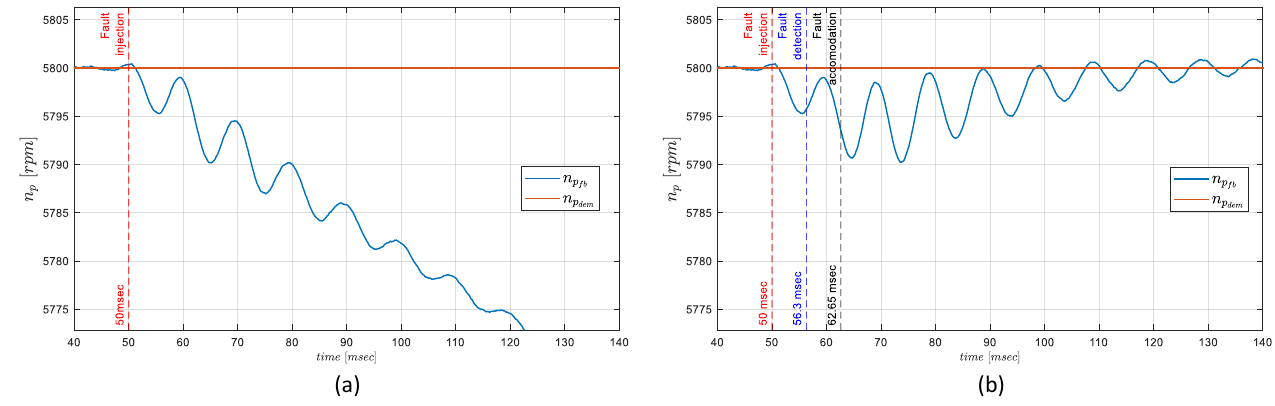
Figure 11. Propeller speed with open circuit on phase a at t = 50 msec: ( a ) without FTC, ( b ) with FTC.